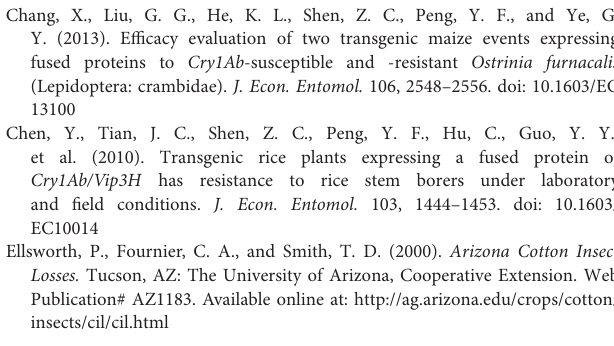
Figure S1 | (A) Ramachandran plot analysis of Cry1Ac protein model to visualize dihedral angles; ϕ against ψ . (B) Ramachandran plot analysis of Vip3Aa protein model to visualize dihedral angles; ϕ against ψ . Figure S2 | Phylogenetic tree based on protein sequences of the aminopeptidase-N (APN) and cadherin receptors of five Lepidopteran insects. The evolutionary history was inferred using the Neighbor-Joining method. The optimal tree with the sum of branch length = 4.07705262 is shown.